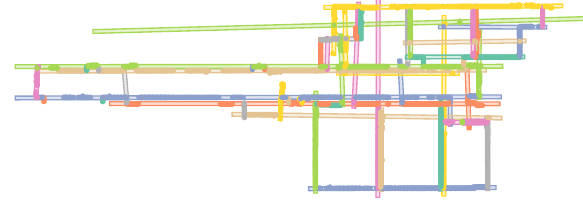
Figure 3. Results of the vanishing point clustering. Lines that do not conform to the dominant orientations have been